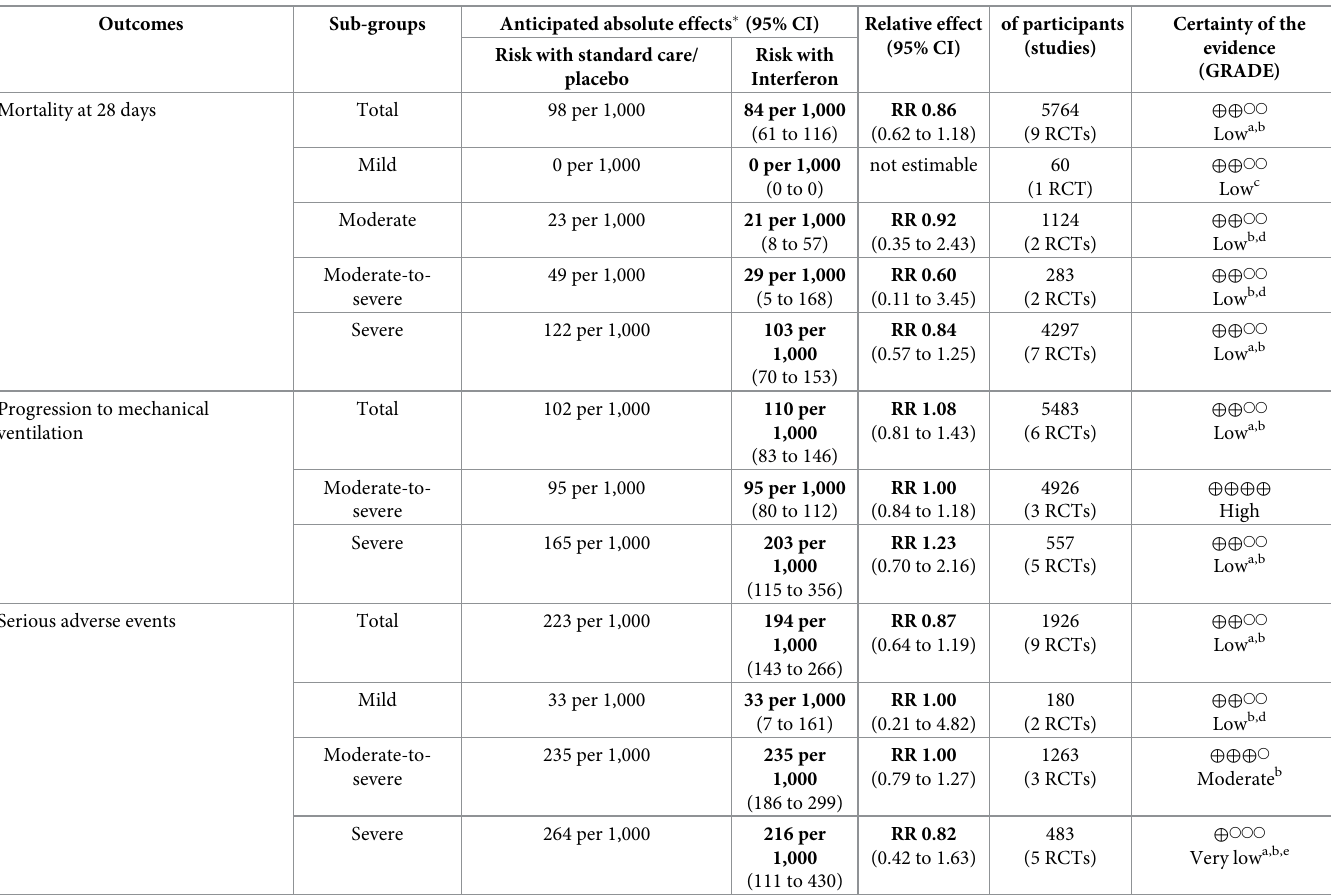
Table 2. GRADE summary of findings table of mortality, progression to invasive mechanical ventilation, and serious adverse